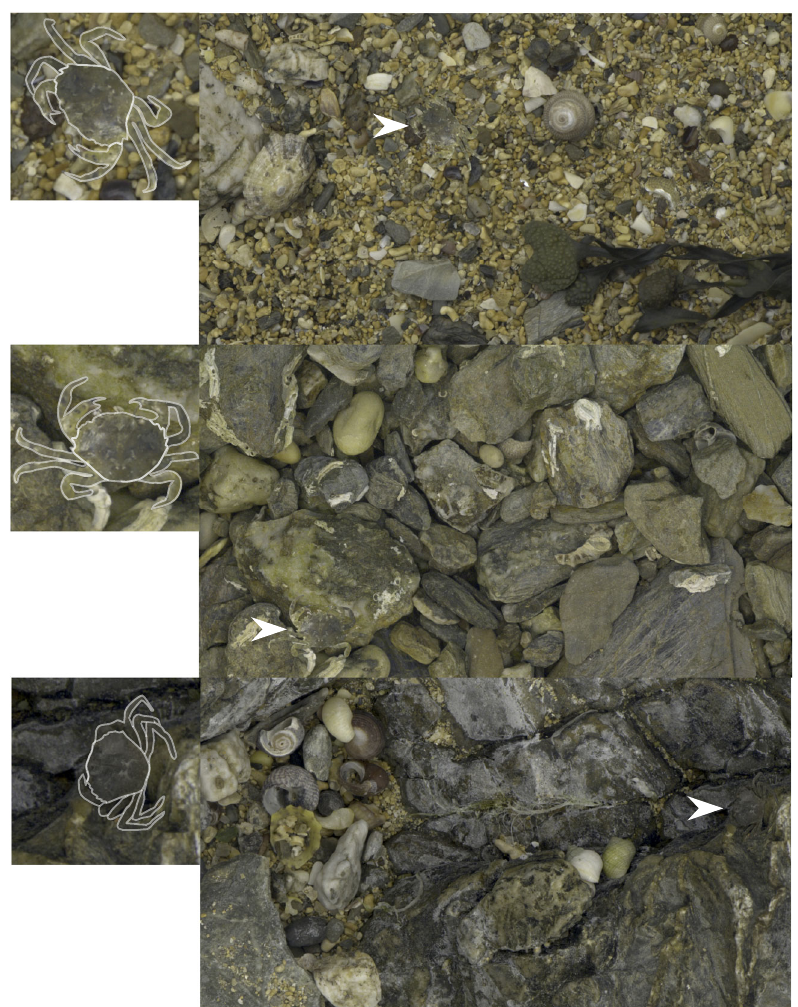
Fig. 2 Sample game images. Example screen shots of the crab search game. Boxes on the left show the crabs enlarged with their outline highlighted. White arrows highlight the locations of the crabs in the